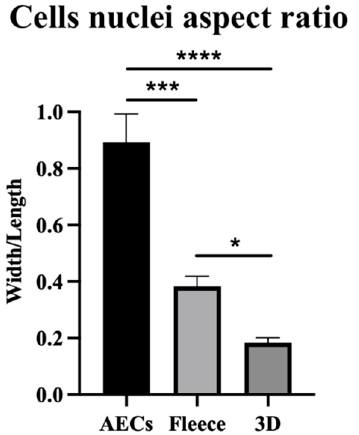
Figure 4. Cells nuclei aspect ratio (width/length) of AECs on PLGA fleeces and 3D scaffolds. AECs on Petri dishes maintain their typical epithelial shape, whereas they acquire an elongated morphology already at 48 h culture on fleeces and 3D scaffolds. *, ***, and **** Statistically significant values between the different studied groups ( p < 0.05; p < 0.001; and p < 0.0001, respectively).